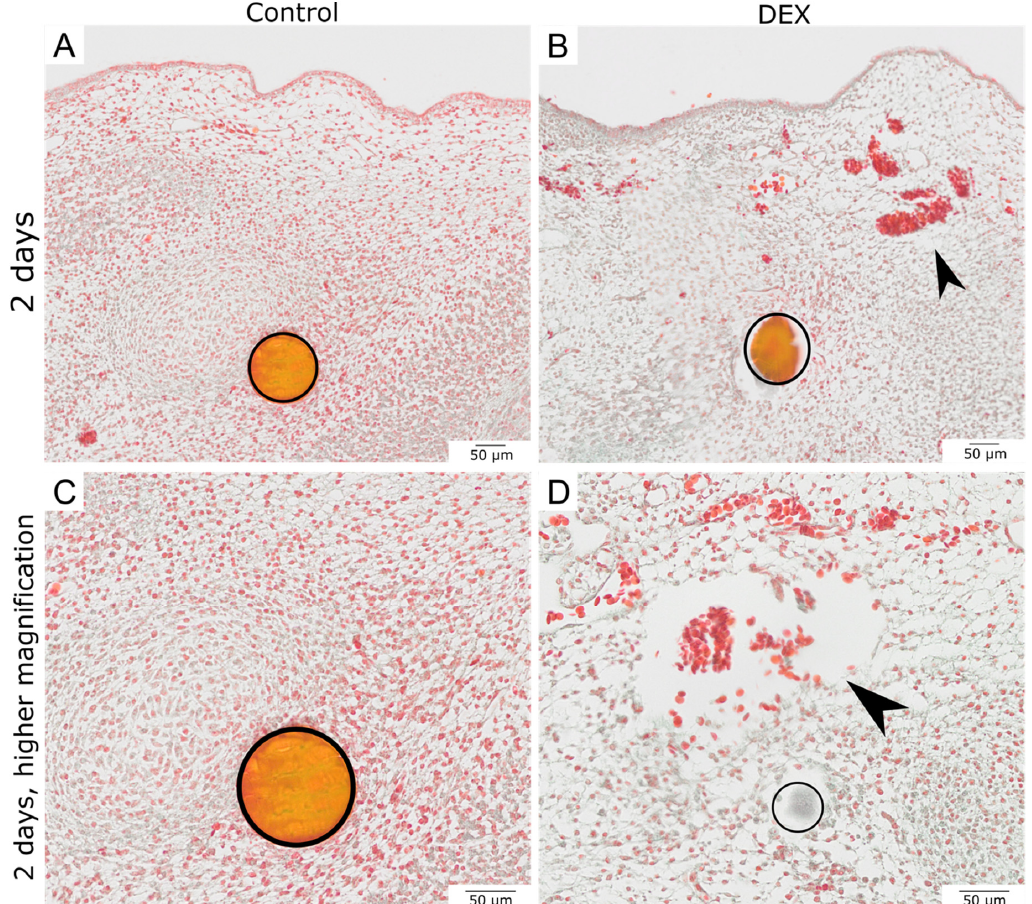
Figure 2. Masson-Goldner-Trichrome staining of bead-implanted wounds after two days. The images show control and dex wounds after two days in an overview ( A , B ) and in higher magnification ( C , D ). The Masson-Goldner-Trichrome-Staining visualizes the impairment of wound healing after two days caused by the dex beads. The subcutaneous hematoma in the mesenchyme appears prominently in the dex wounds